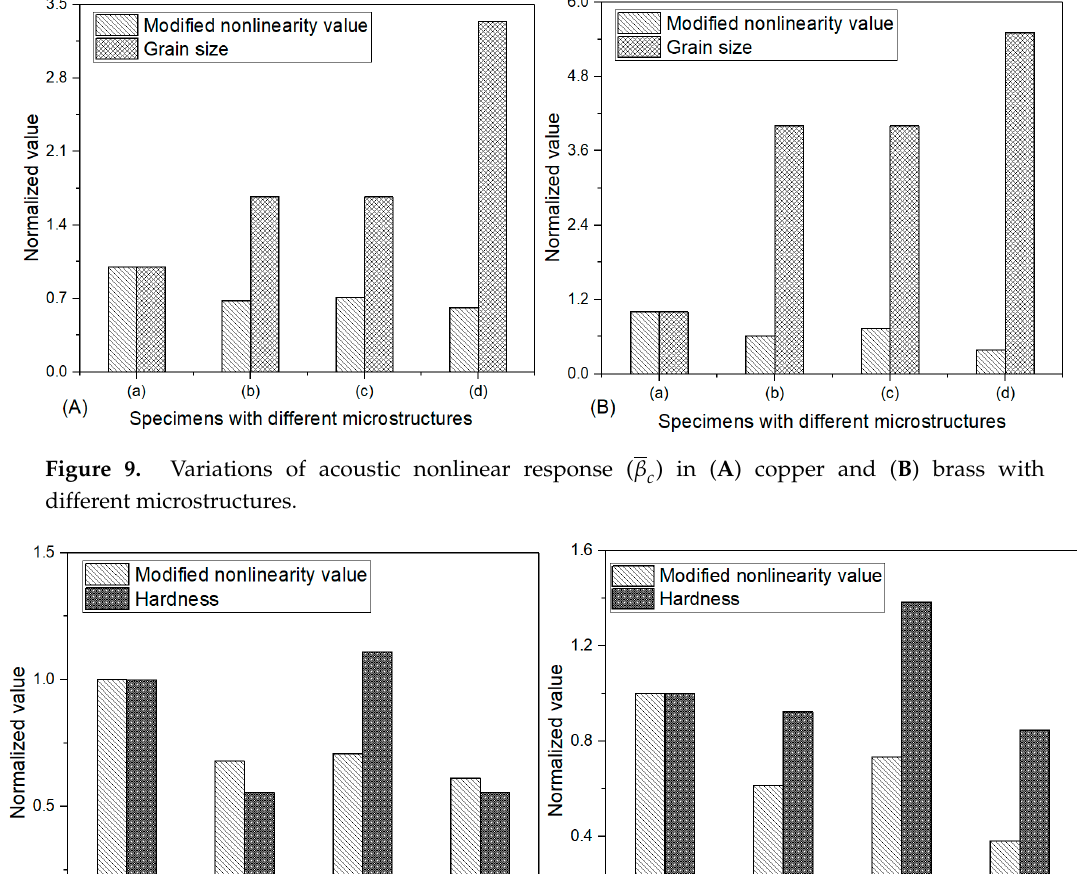
) in ( A ) copper and ( B ) brass with c